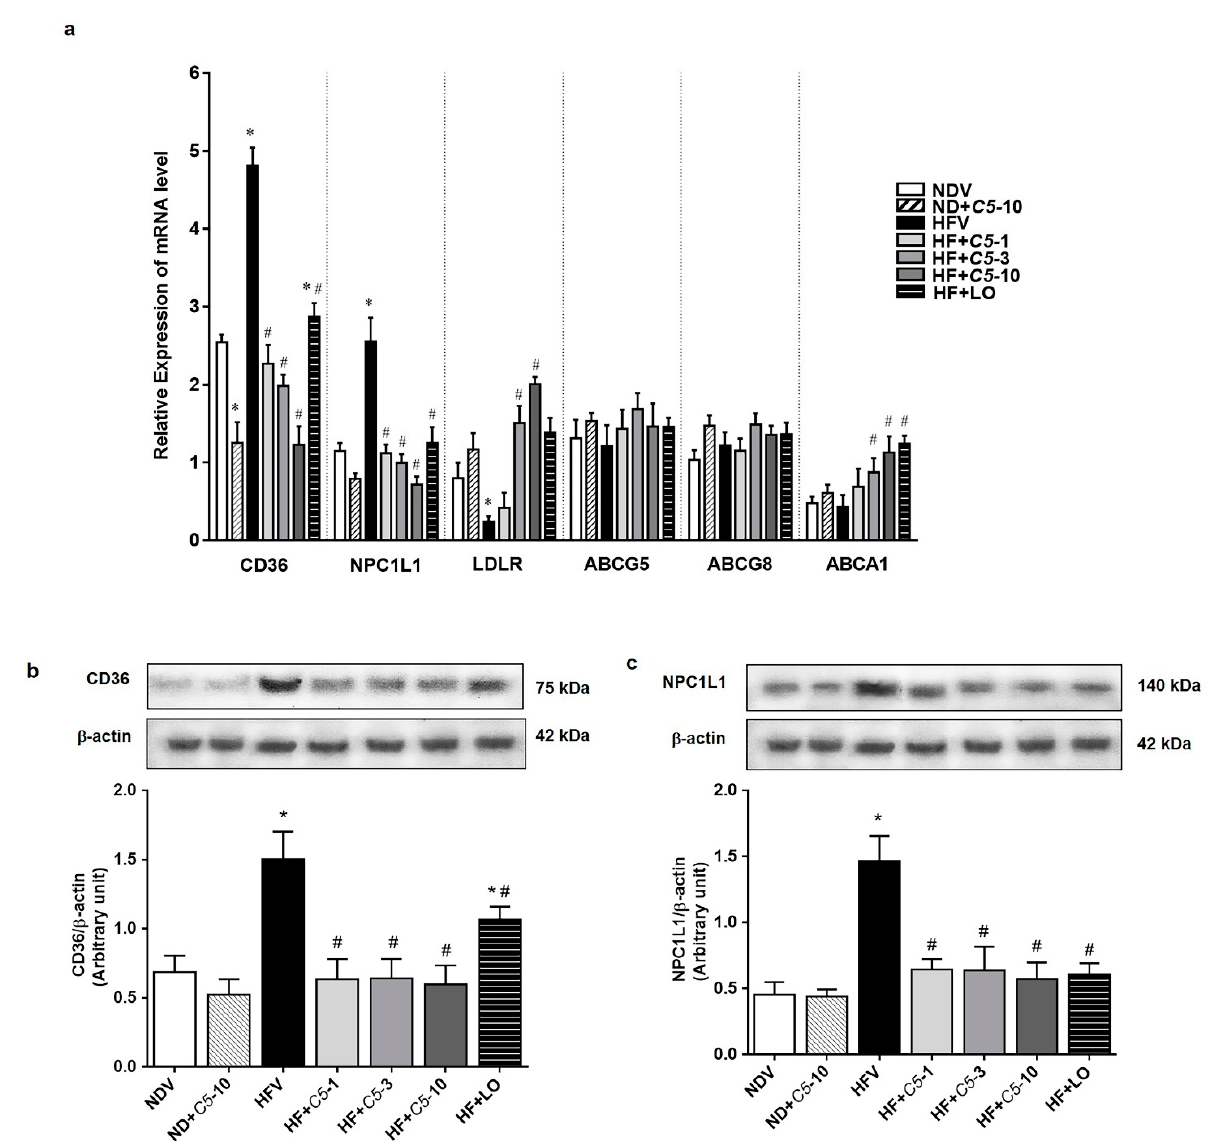
Figure 5. α , β -dehydromonacolin S ( C5 ) modulates lipid transporter gene and protein expression. ( a ) The mRNA expression of lipid transporters including CD36, NPC1L1, LDLR, ABCG5/8 and ABCA1 were quantitatively determined using qPCR. ( b ) CD36 and ( c ) NPC1L1 protein expression extracted from rat liver tissue were analyzed by Western blotting. A representative blot of CD36 and NPC1L1 protein expression is shown on the top panel and quantification of relative protein expression in each experimental group presented on the bottom. Anti- β -actin antibody was used as loading control. Values are mean ± S.E.M ( n = 5). * p < 0.05 represents the significant difference compared with the NDV group and # p < 0.05 represents the significant difference compared with the HFV group.